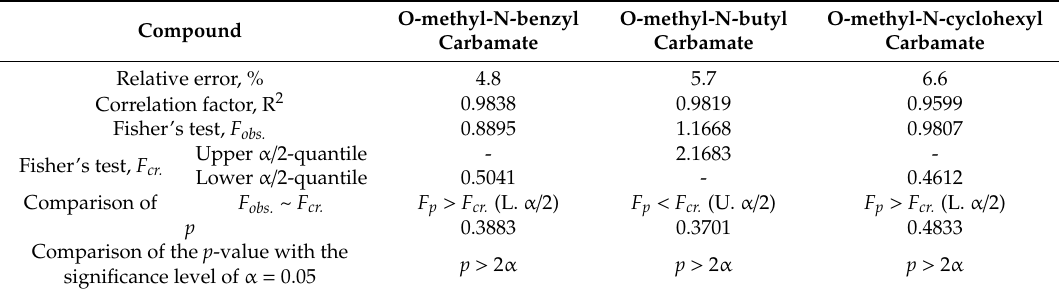
Table 12. Statistical processing of the experimental and calculated fractional